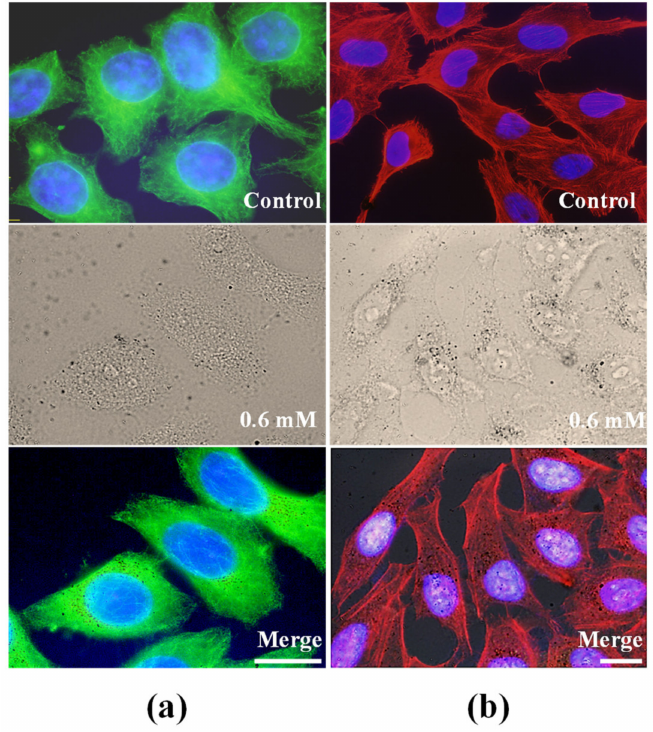
Figure 6. Analysis of cytoskeleton in HeLa cells incubated 24 h with 0.6 mM metal concentration and observed under fluorescence and bright-field microscopy immediately after incubations. ( a ) Immunofluorescence staining of α -tubulin observed under blue light excitation. ( b ) TRITC-phalloidin visualization of actin microfilaments observed under green light